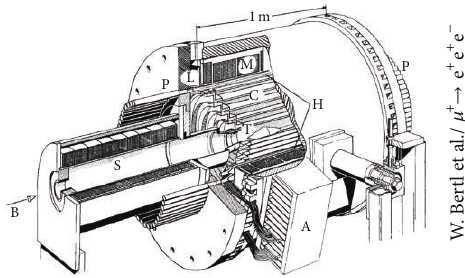
Figure 18: Schematic view of the SINDRUM